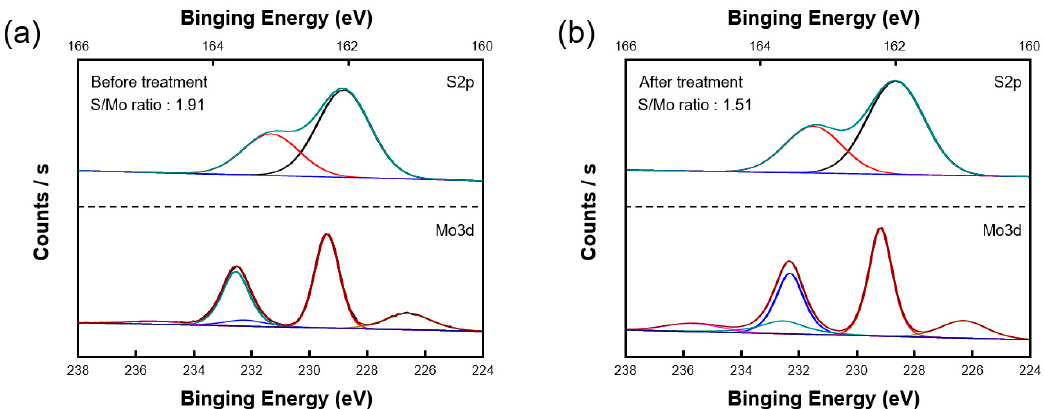
Figure 4. Chemical compositions of MoS 2 films ( a ) before and ( b ) after plasma treatment. After the plasma treatment, the S / Mo ratio decreased from 1.91 to 1.51, indicating the creation of sulfur vacancies.